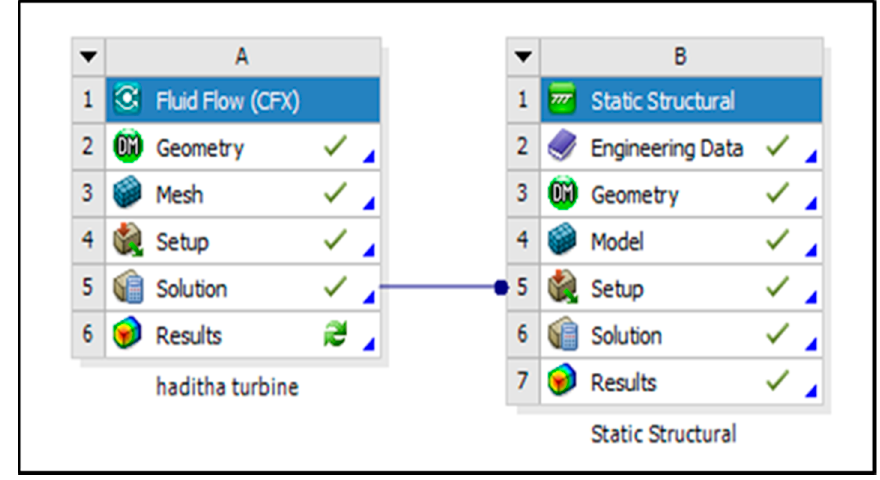
Figure 6. The connection between the ANSYS-CFX solution and the STATIC-STRUCTURAL setup.